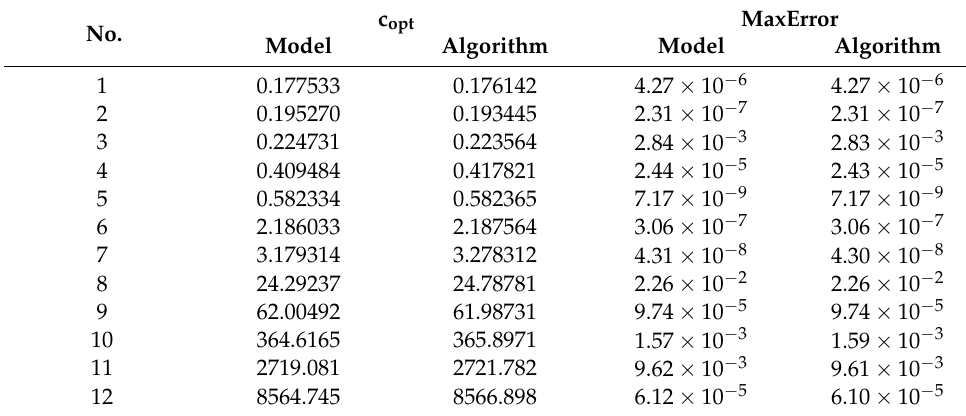
Table 11. Results of verification